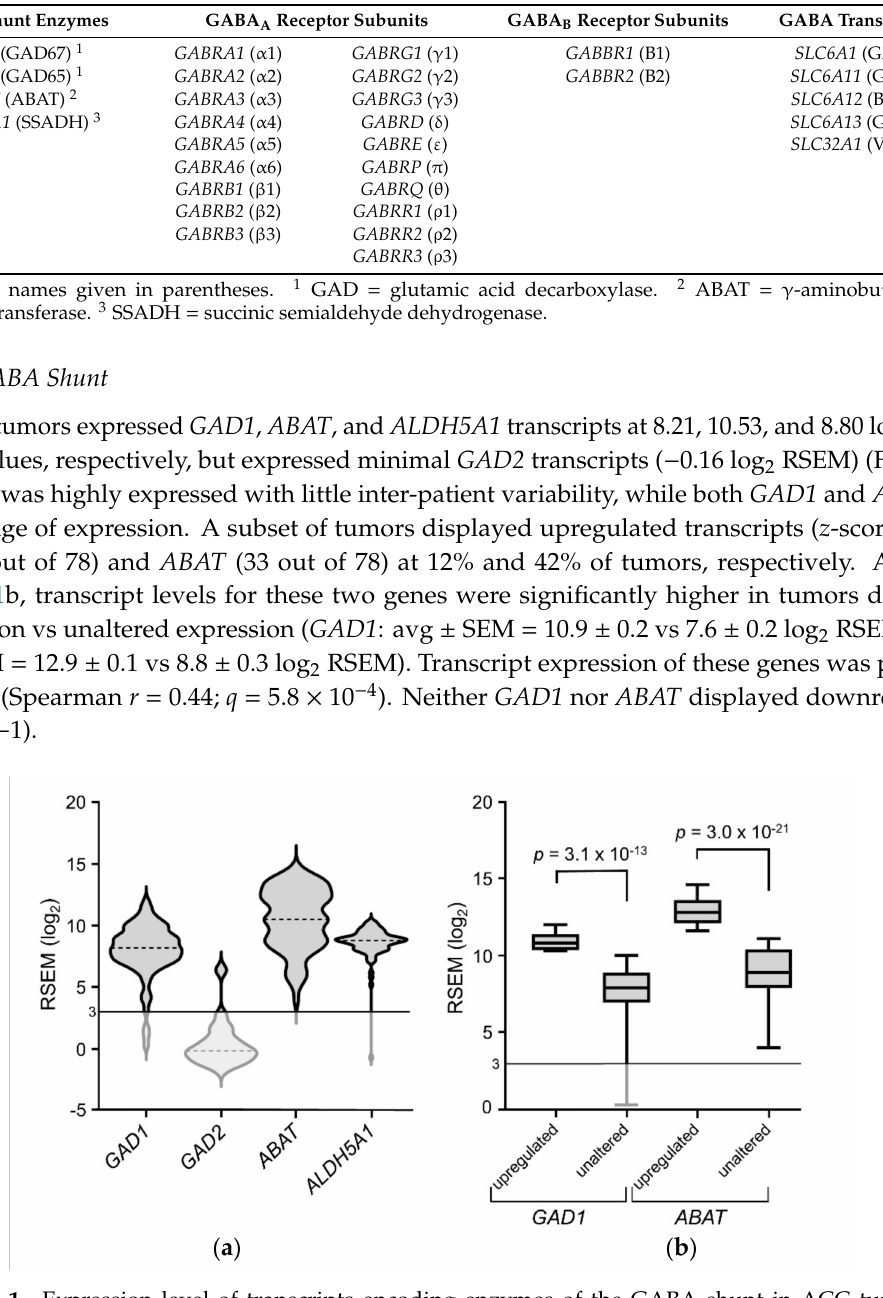
Figure 1. Expression level of transcripts encoding enzymes of the GABA shunt in ACC tumors. ( a ) Volcano plots depicting GABA shunt gene expression; dotted lines represent median expression levels. ( b ) Box-and-whisker plots representing expression of GAD1 and ABAT transcript levels in tumor samples, upregulated vs unaltered, unpaired t